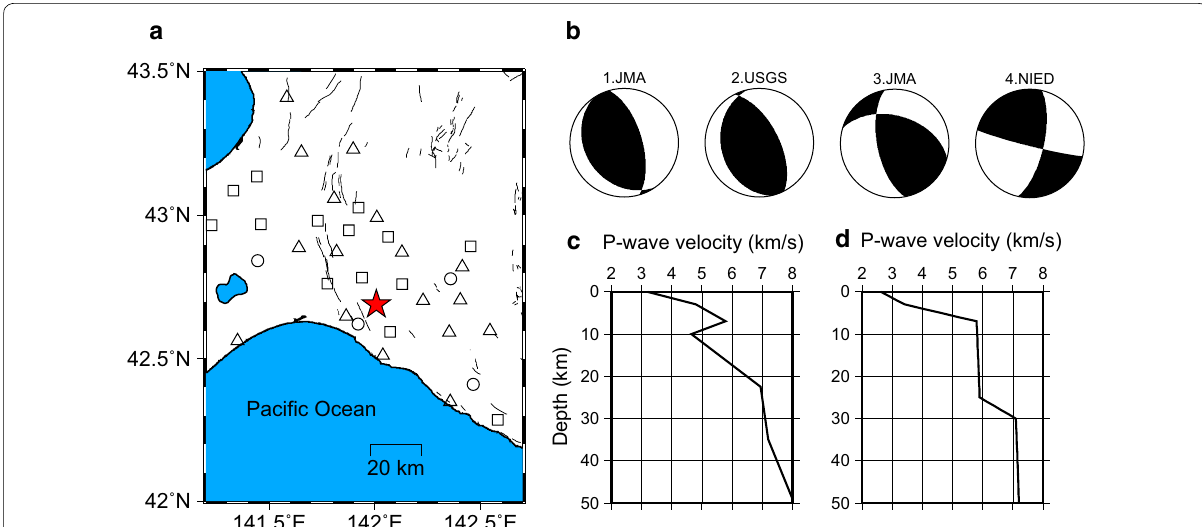
Fig. 1 a Seismic stations are used in this study. Squares and circles are stations maintained by Hokkaido University and JMA, respectively. Triangles are the Hi-net or F-net stations maintained by NIED. A red star marks the epicenter of the 2018 Hokkaido Eastern Iburi earthquake located by JMA. Thin lines indicate surface traces of active faults (Research Group for Active Faults in Japan 1991). b 1. JMA and 2. USGS are the CMT solutions of the main shock determined by JMA (2018a) and USGS (2018), respectively. 3. JMA and 4. NIED are the focal mechanism solutions of the main shock by using the first-motion polarities of the P wave determined by JMA (2018b) and NIED (2018b), respectively. c P wave velocity structure assumed for calculating the initial hypocenters before the hypocenter determination using a 3-D velocity structure. d Optimal P wave velocity structure obtained from the homogeneous station